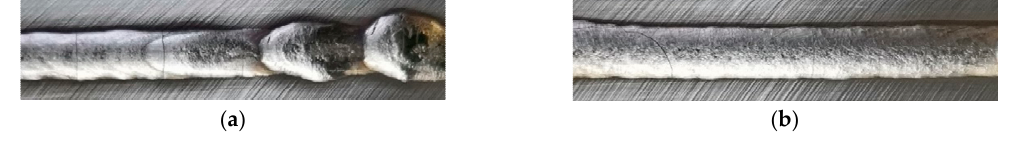
Figure 14. Deposition result: ( a ) deposition within the open-loop control; ( b ) deposition within the closed-loop control.